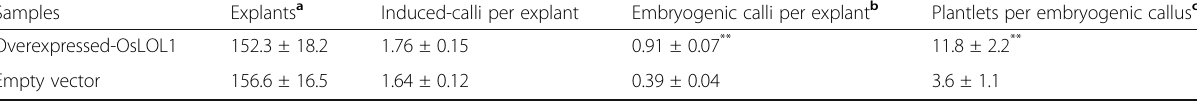
Table 1 Cotton callus induction, somatic embryogenesis, and regenerating plantlets